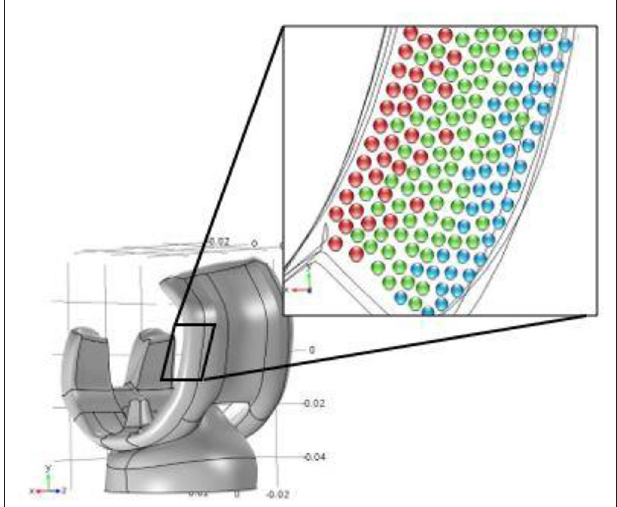
FIGURE 1 | The schematic of material properties distribution in a cross section of the functionally graded biomaterial; red spheres: HA, green spheres: Ti, blue spheres: Al2O3 or